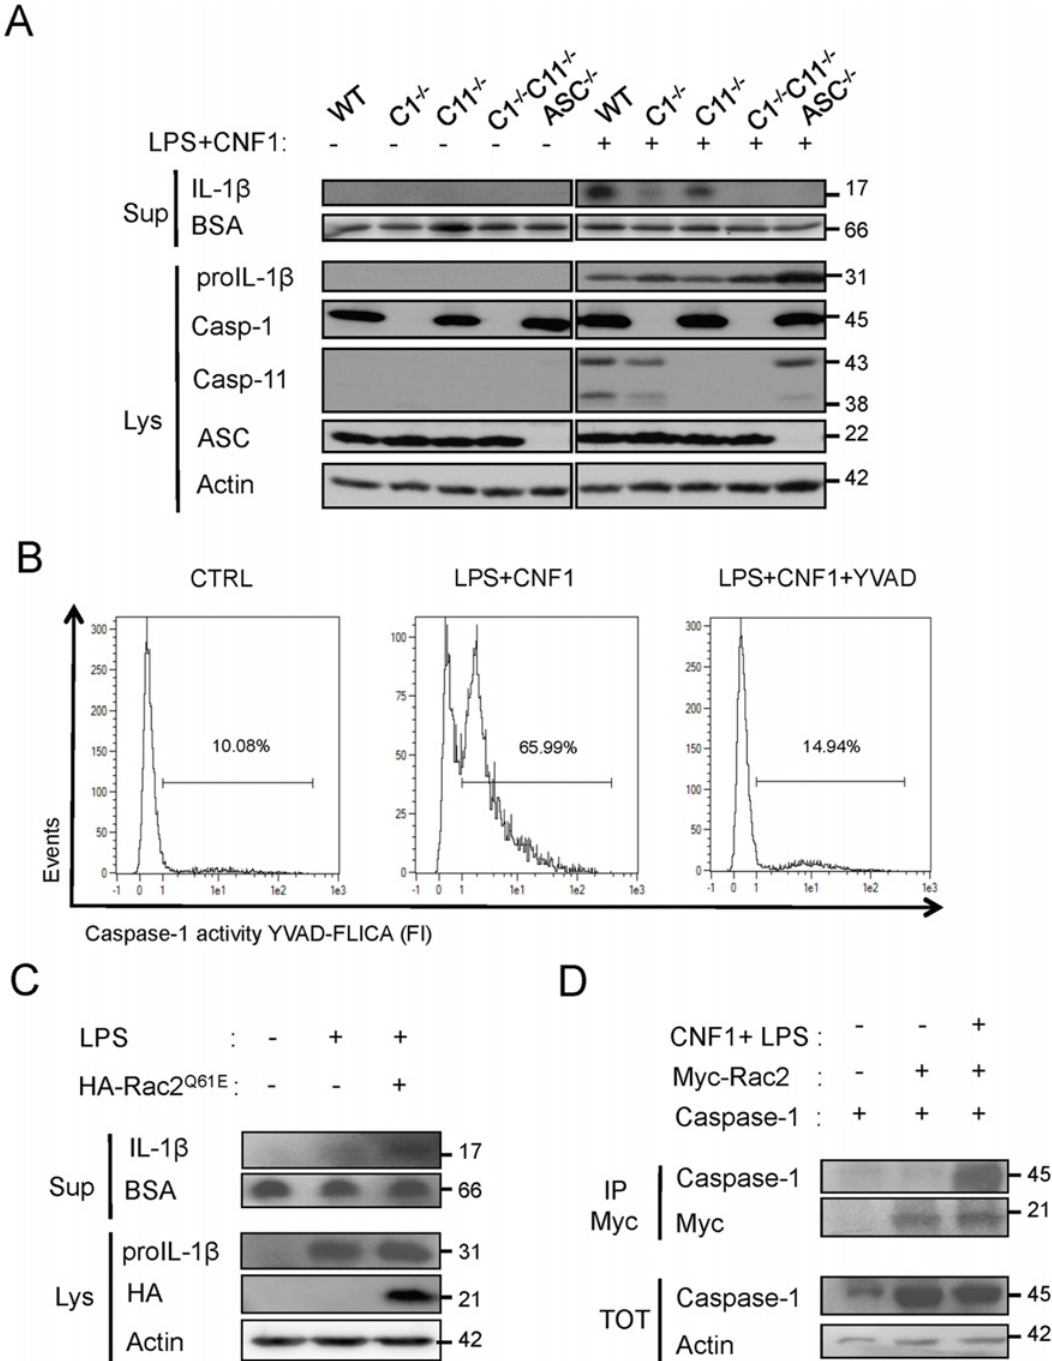
Fig 4. CNF1-triggered IL-1 β maturation requires activated Rac, ASC and caspase-1. (A) Western blot analysis of the production and maturation/ secretion of IL-1 β by primary macrophages following treatment with CNF1, LPS or CNF1+LPS for 10 h. Actin and BSA were used as loading controls. (B) Quantification of caspase-1 activity in macrophages following treatment with CNF1+LPS for 6 h using YVAD-Fluorescent Labelled Inhibitor Caspase-1 Activity (FLICA). (C) Western blot analysis of macrophages IL-1 β maturation/secretion upon transfection of HA-Rac2 Q61E and LPS treatment. (D) Co- immunoprecipitation of Myc-Rac2 and caspase-1 using an anti-Myc antibody following the treatment of HEK 293T cells with CNF1+LPS for 6 h.